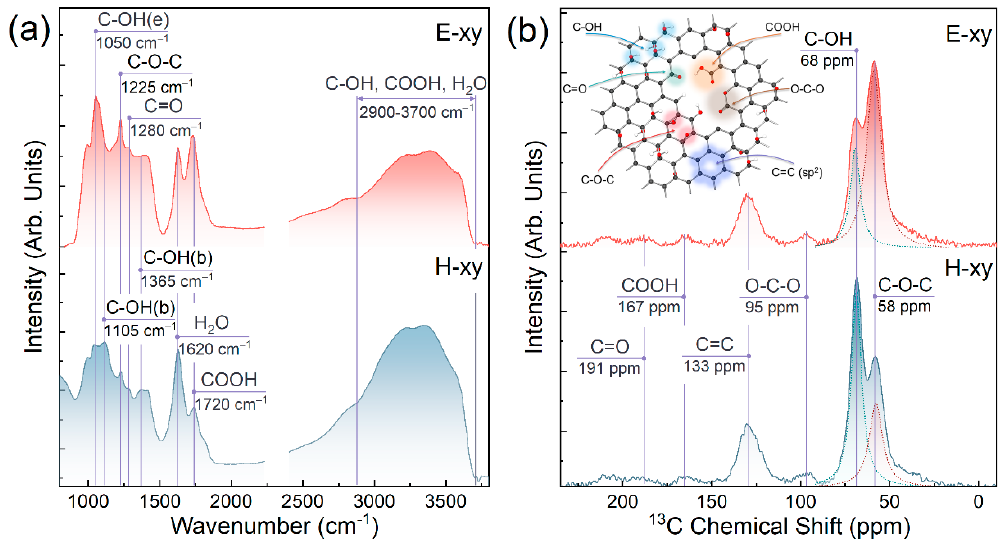
Figure 2. ( a ) FTIR and ( b ) NMR characterization of E-xy and H-xy graphenes. Inset—schematic representation of the GO chemistry.